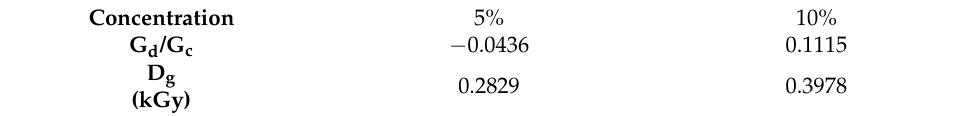
Table 1. Radiochemical yield ratios and initial gel dose of net -GE at different initial GE concentrations.